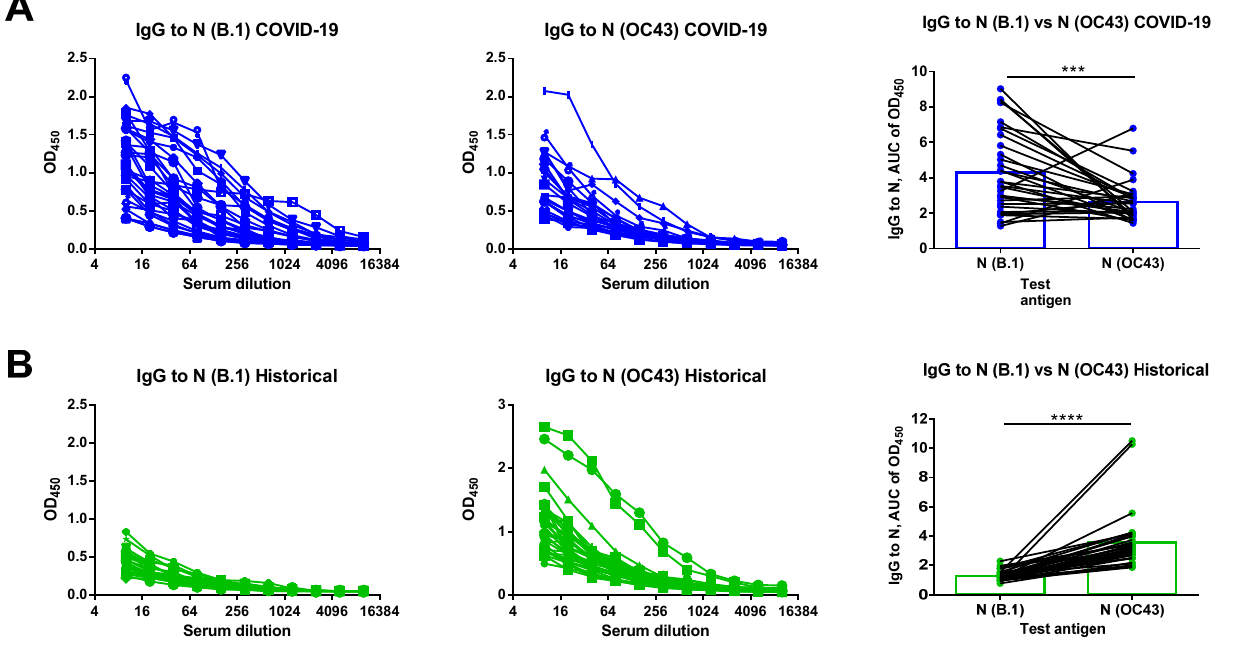
Figure 2. N-based ELISA of serum samples of COVID-19 convalescents ( A ) or historical specimens ( B ). Left panel shows OD 50 curves for N (B.1) antigen for each participant. Middle panel shows OD 50 curves for N (OC43) antigen for each participant. Right panel shows comparison of the area under the OD 450 curve (AUC) values for the two N antigens. The dataset included sera from patients who recovered from COVID-19 ( n = 32, blue symbols) and historical serum samples ( n = 36, green symbols). The data were compared by the Wilcoxon matched pairs test. *** p < 0.001; **** p < 0.0001.